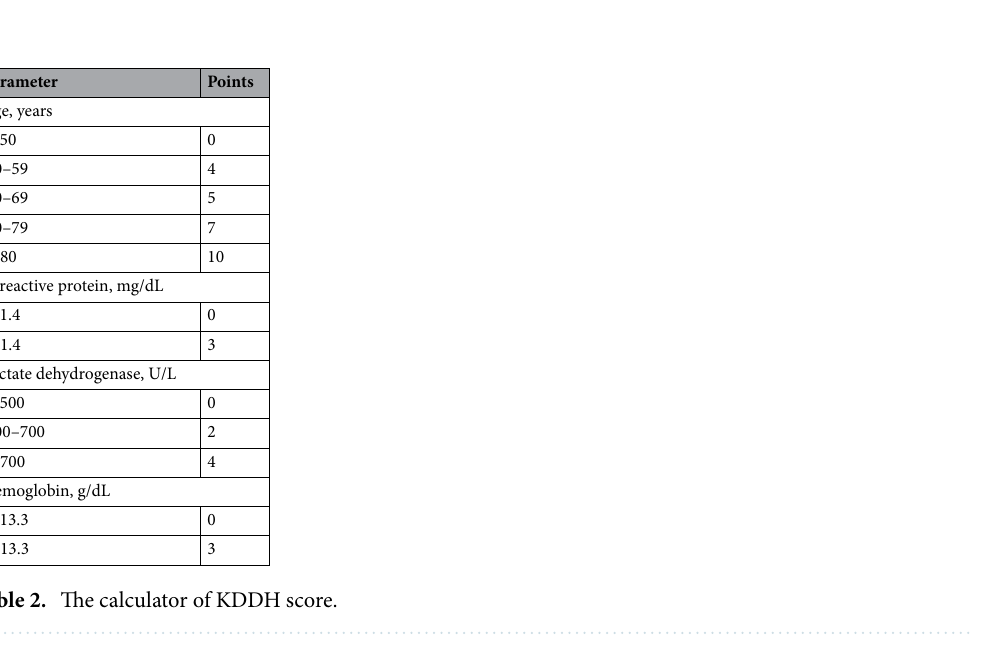
Table 1. Univariate and multiple logistic regression analysis in the development cohort. ALC, absolute lymphocyte count; ALT, Alanine aminotransferase; ANC, absolute neutrophil count; CI, confidence interval; AST, Aspartate aminotransferase; BUN, blood urea nitrogen; CPK, Creatinine phosphokinase; CRP, C-reactive protein; CXR, chest X-ray; eGFR, estimated glomerular filtration rate; LDH, lactate dehydrogenase; OR, odds ratio.